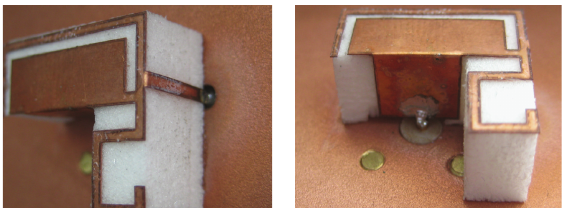
Figure 3: Photos of the tri-band antenna showing the ground and feeding strips.